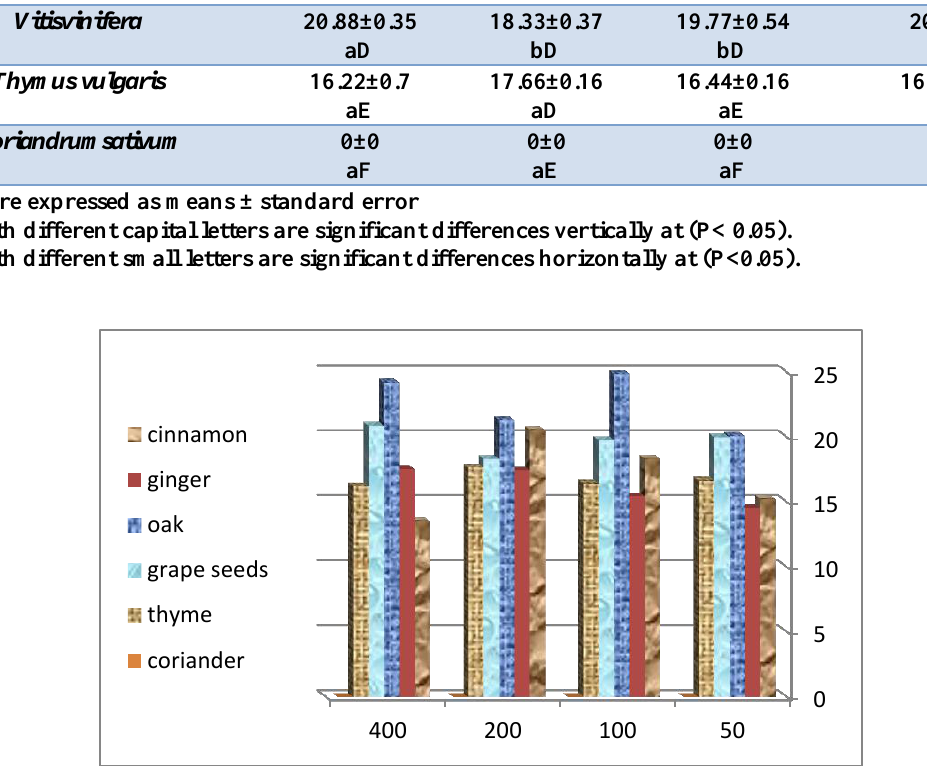
Figure, 1: Zone of inhibition (mm) of Proteus spp. exhibited by the ethanolic extracts of the tested plants